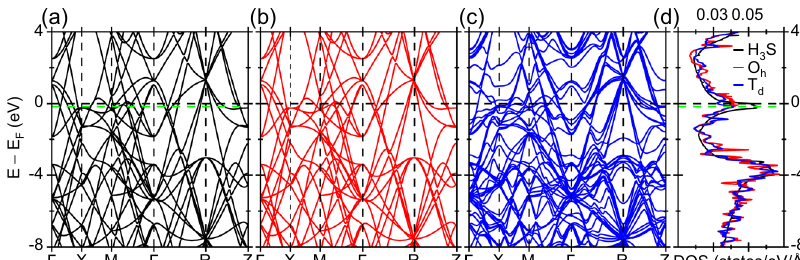
Fig. 3 Band structure and density of states at 270 GPa. a Im 3 m H 3 S in a 2 × 2 × 2 supercell of the standard conventional lattice, b Pm 3 m O h -CS 15 H 48 , and c Amm 2 T d -CS 15 H 48 . To compare the band structures of the three phases, which all possess different space-groups, simple cubic symmetry is assumed and the high symmetry special points used are Γ (0,0,0), X (0.5,0,0), M (0.5,0.5,0) and R (0.5,0.5,0.5). d Densities of states of these phases where O h denotes CS 15 H 48 with hexacoordinate carbon and T d with tetracoordinate carbon. The black horizontal dashed line denotes E F and the green dashed line E F − 0.17 eV, which corresponds to the top of the peak in the DOS in Im 3 m H 3